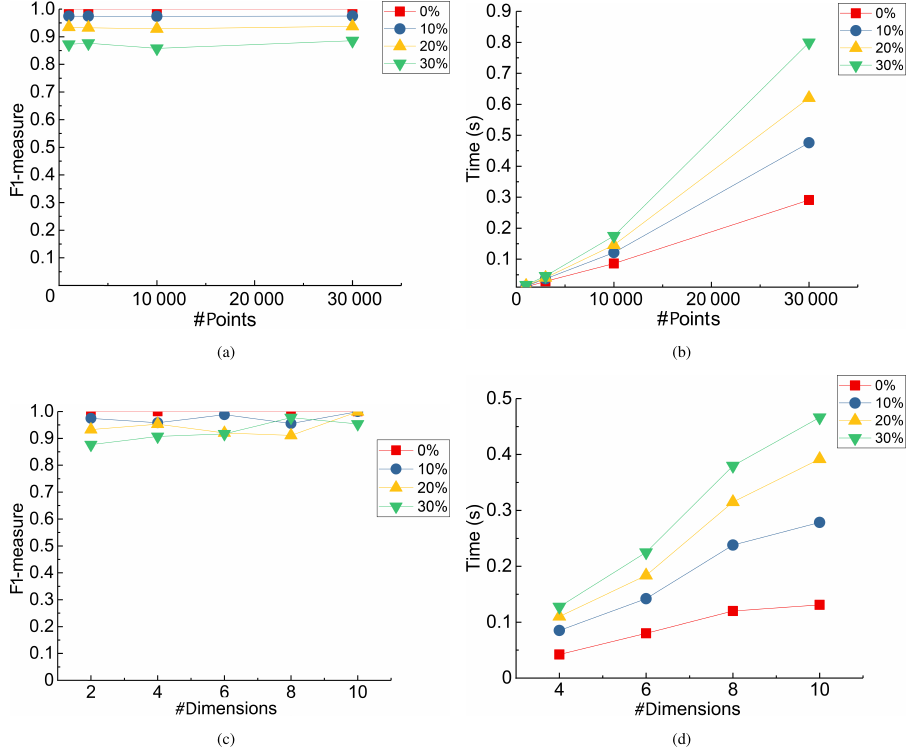
Fig. 8 Experimental results of LI-clustering with different missing rates (0%, 10%, 20%, and